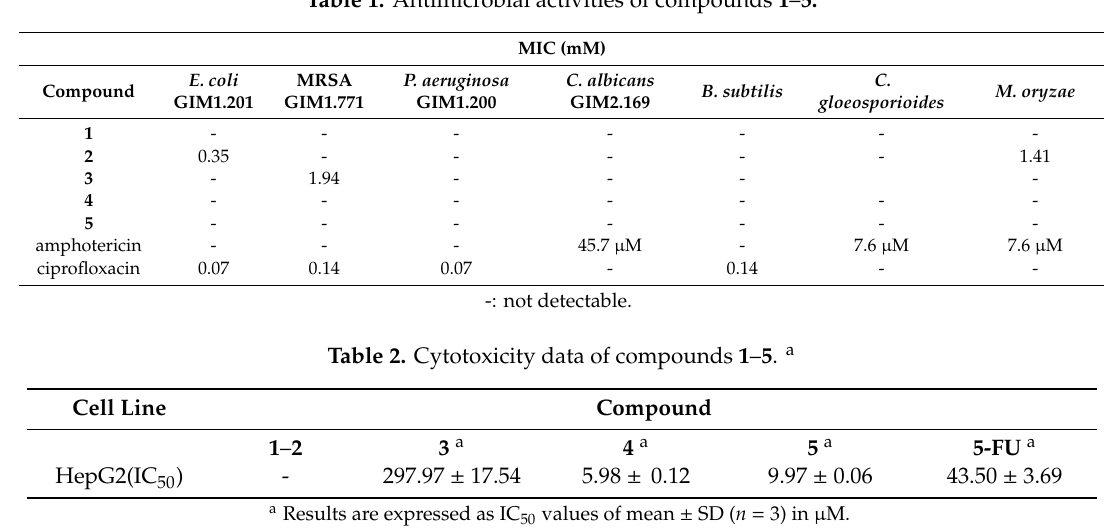
summarized in Table 1. Compound 1 − 5 were also tested in vitro against the human cancer cell line HepG2 with 5-fluorouracil as the positive control. Among them, compound 2 exhibited weak inhibitory activity against E. coli GIM1.201 (minimum inhibitory concentration (MIC) = 0.35 mM) and M. oryzae